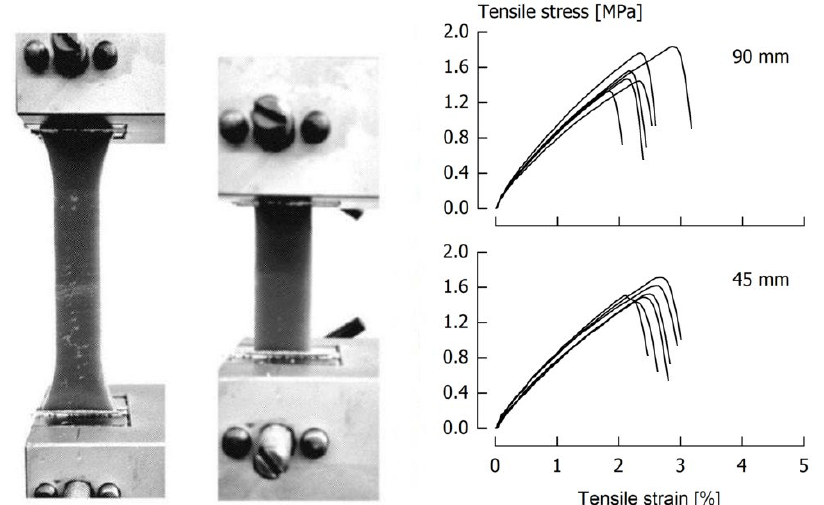
Figure 3. Tensile clamps with specimens fixed at a clamping distance of 90 mm or 45 mm, and the resulting stress/strain curves of repeated tests performed at v = 2500 mm/min.